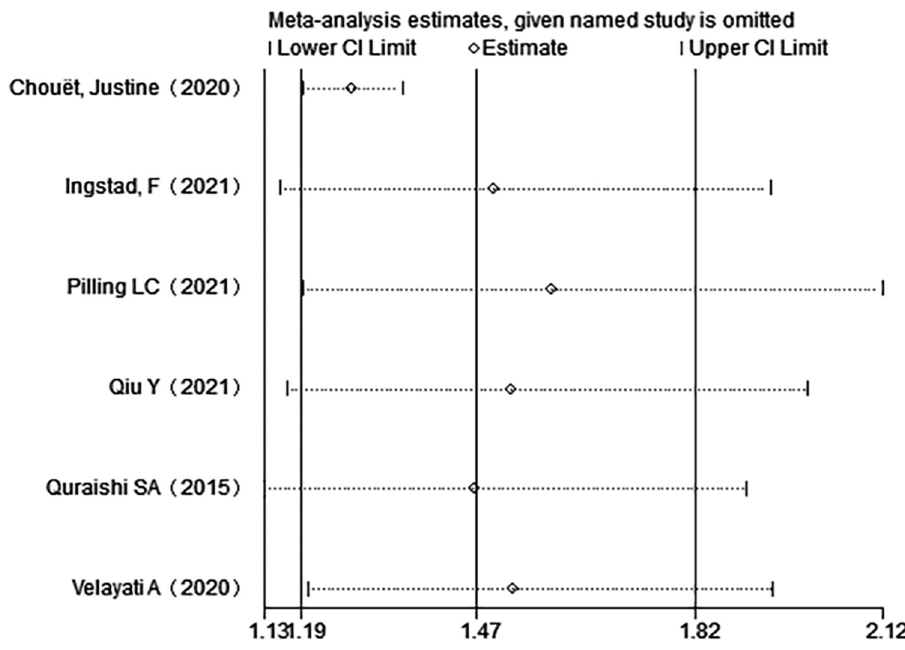
Fig 2. Sensitivity analysis when 50 nmol /L was used as the